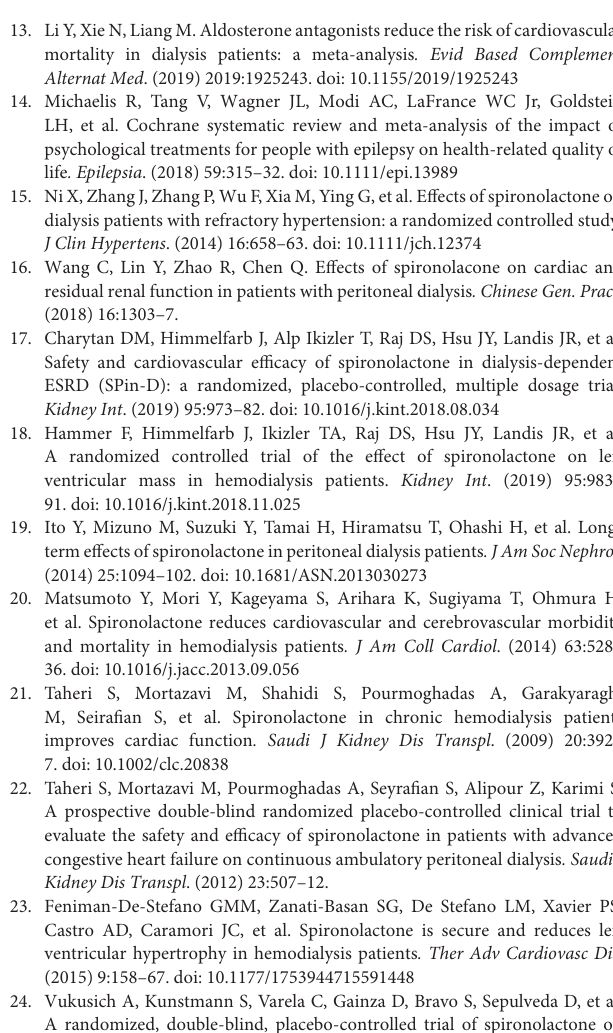
Supplementary Figure 1 | Graphic abstract. Supplementary Figure 2 | Subgroup analysis based on